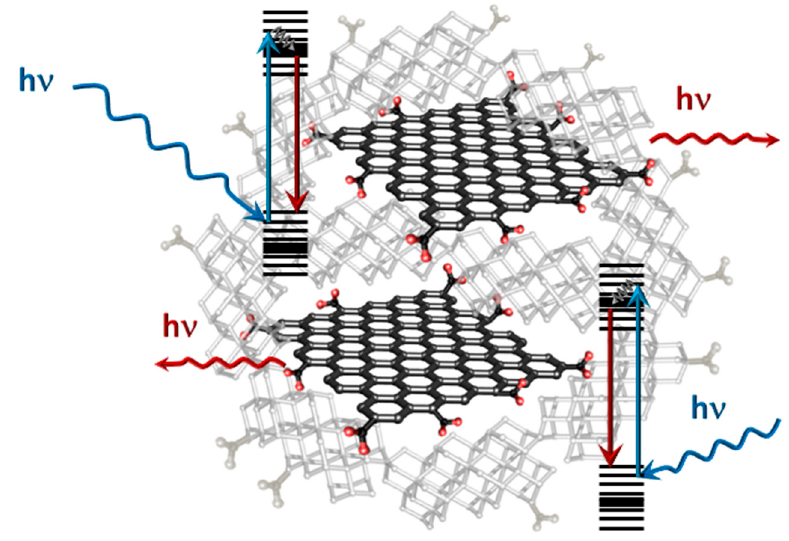
Figure 6. Sketch of a carbon QD with its defined sp 2 domains isolated and surrounded with diamond- like carbon which is highly oxidized on the surface of the particle.